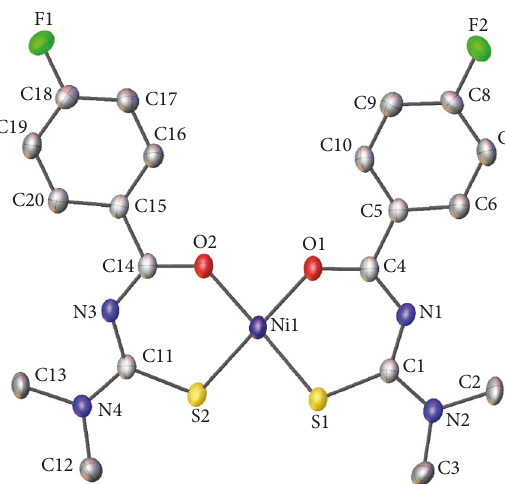
Figure 4: Molecular structure of NiL 2 with anisotropic displace- ment ellipsoids drawn at 50% probability level. H-atoms omitted for clarity.